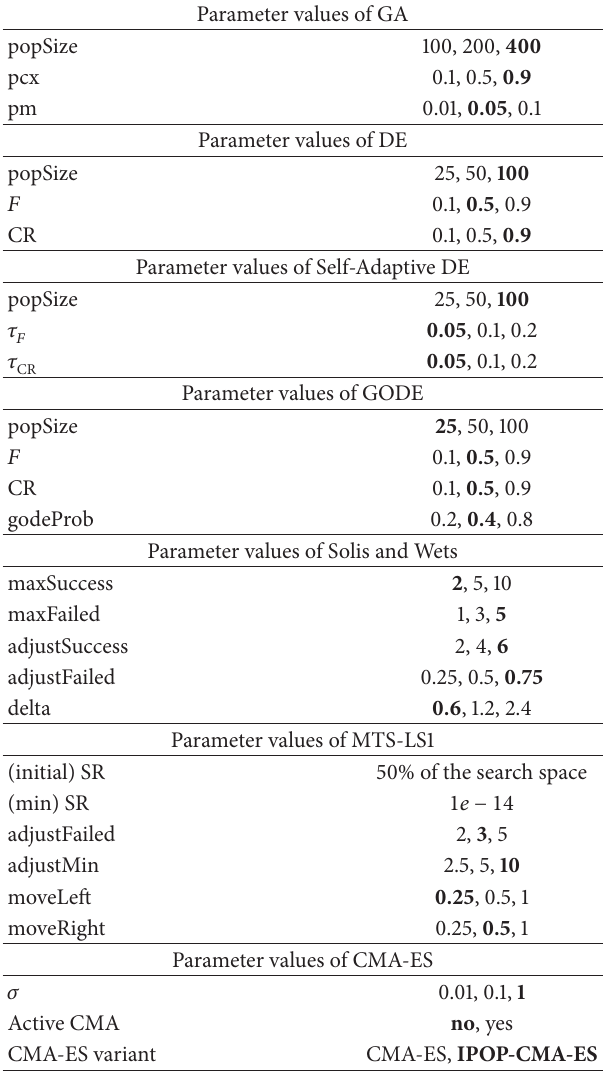
Table 1: Parameter tuning of the selected metaheuristics.